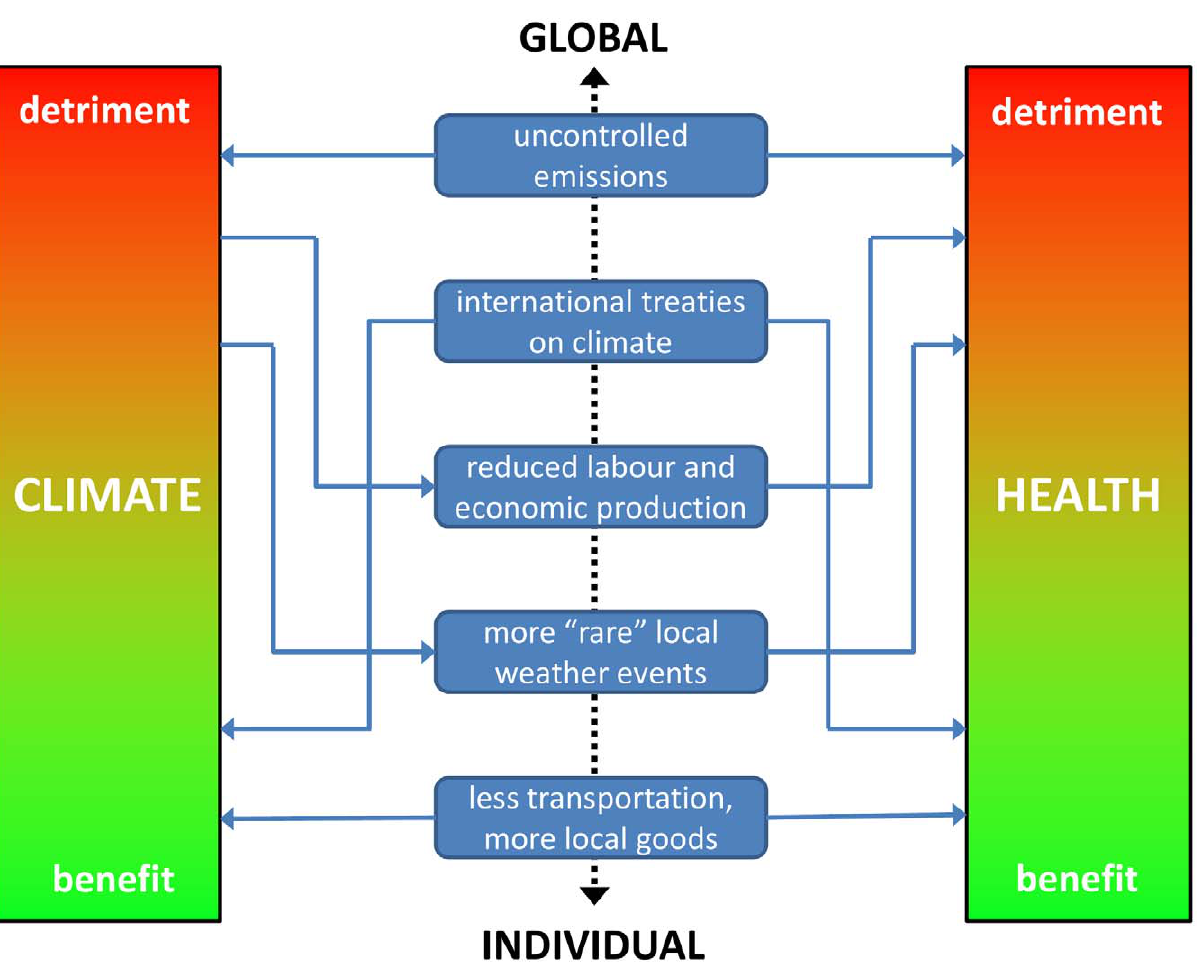
Figure 1. Schematic of inter-relationships between climate and health, with examples of determinants on a global to individual scale.